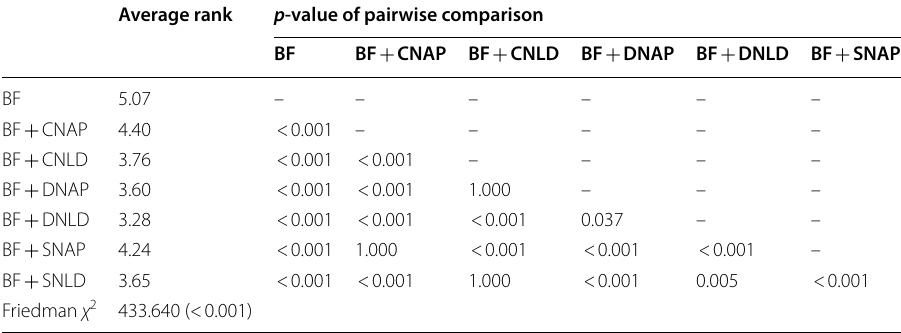
Table 23 Results of full pairwise comparison (BF, BF BF SNAP, and BF +